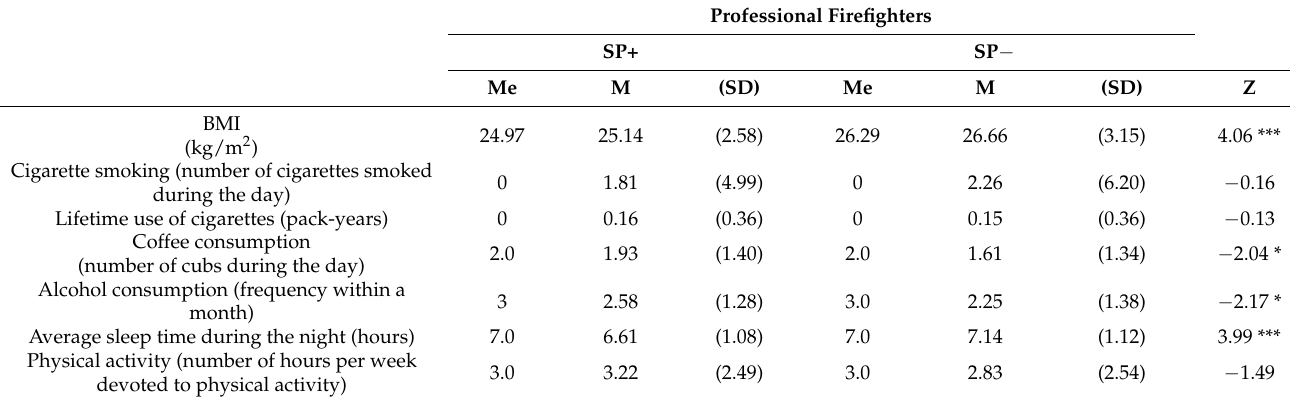
Table 5. Lifestyle differences between firefighters who experienced at least one SP in their lives and those who never experienced